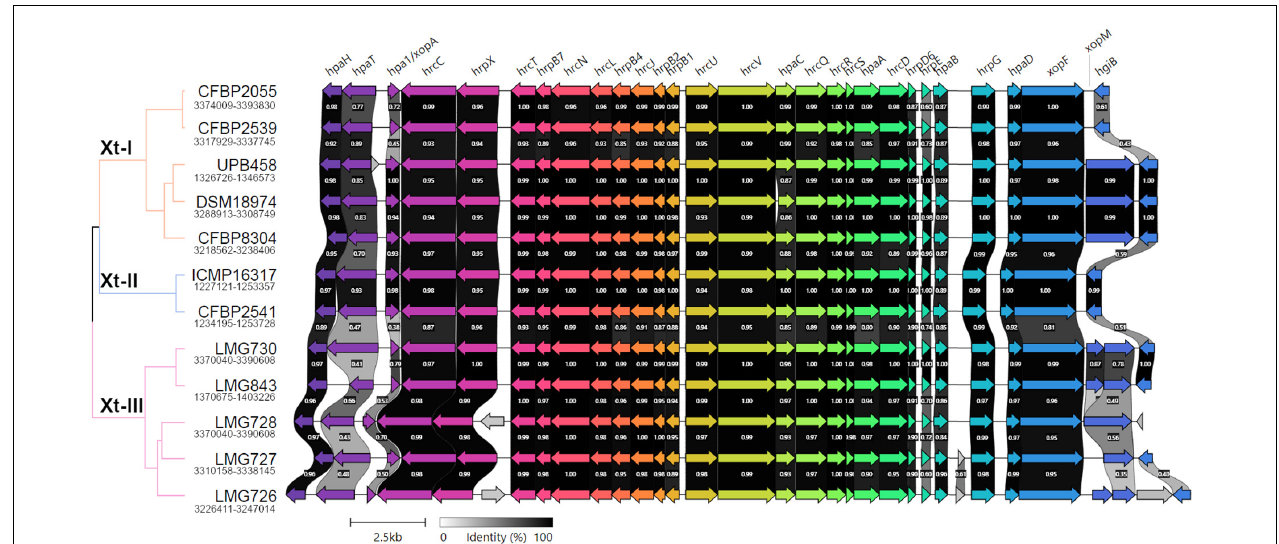
FIGURE 5 | Pairwise comparisons of the genetic content of the type III secretion system cluster in the X. translucens pathotype strains obtained with Clinker (Gilchrist and Chooi, 2021). The phylogenetic tree is based on ANI as shown in Figure 1 , orange: Clade Xt-I, blue: clade Xt-II, pink: clade Xt-III. Colors of the arrows represent groups of similar genes. Clusters for strains ICMP 16317, CFBP 2541, and LMG 727 are found in opposite direction and were reversed in the figure.